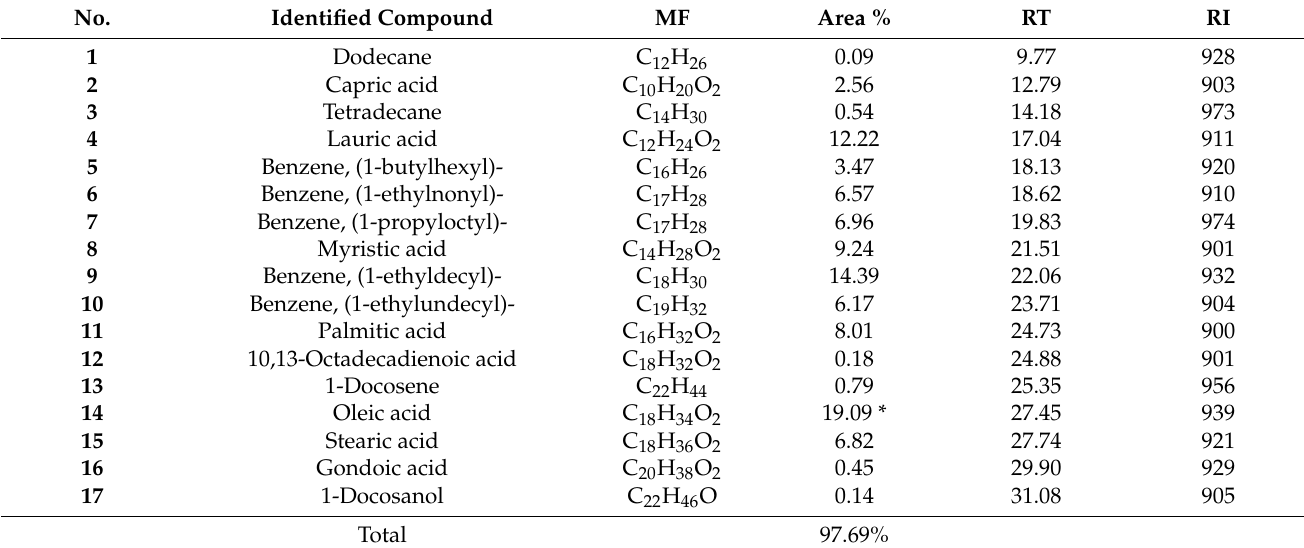
Table 1. Cocos nucifera seed oil composition using GC/MS analysis.